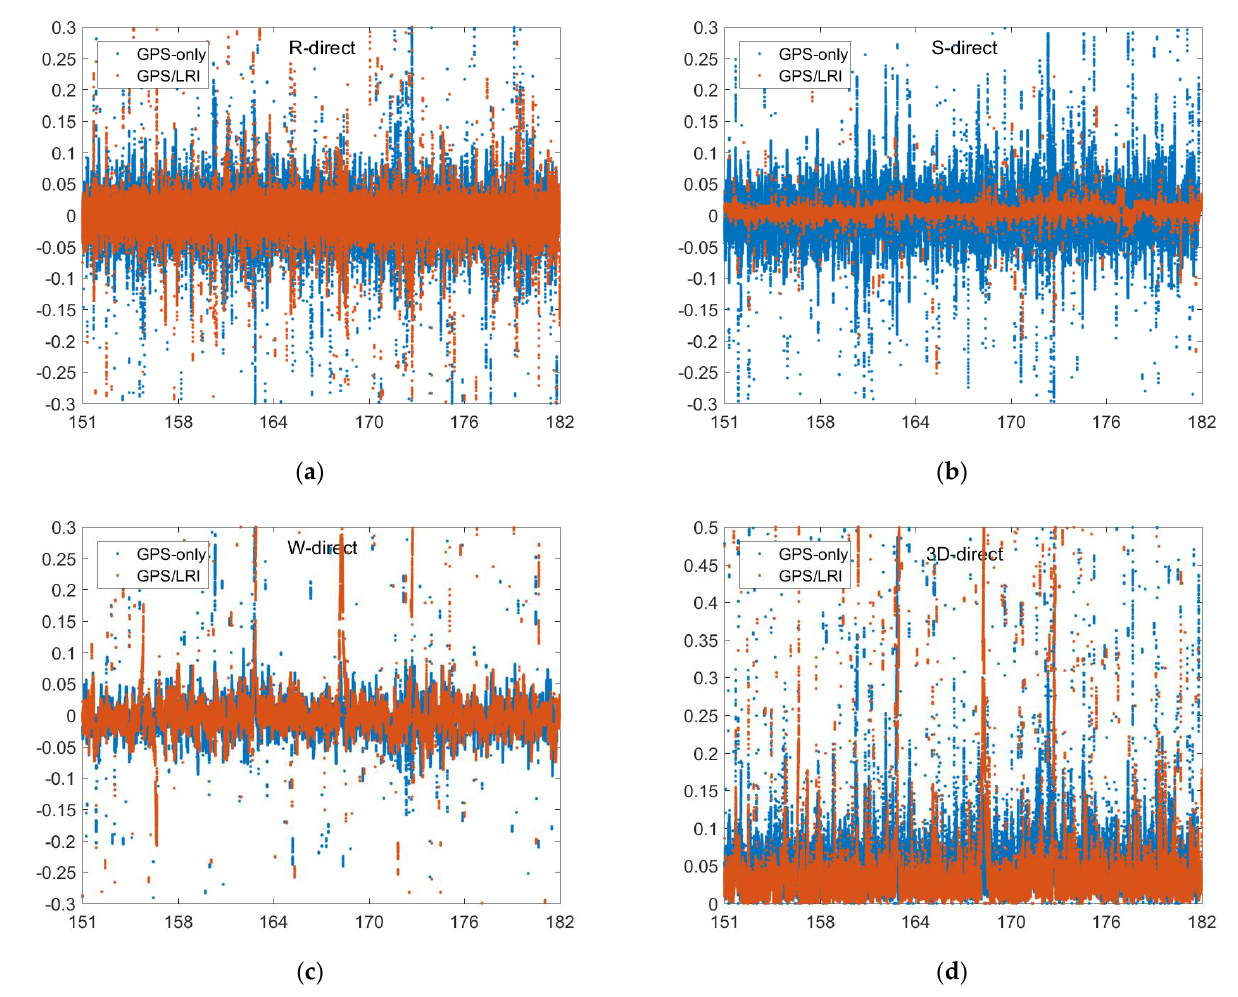
Figure 7. Reference orbit check for GRACE-FO-A in the R, S, W, 3D directions (days 121-151, ( a – d )).